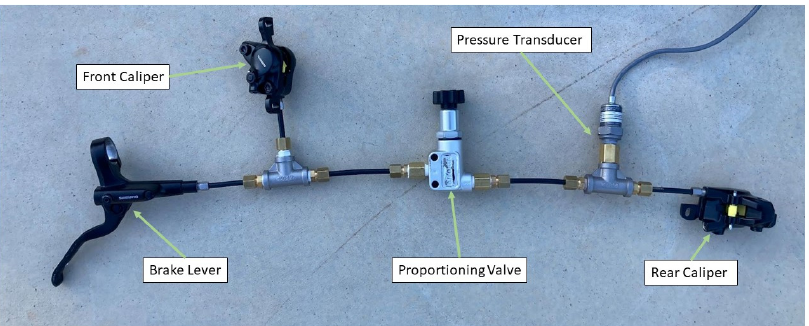
Figure 7. Bench-top prototype brake system including a proportioning valve and pressure transducer (force sensors omitted). Mass, as shown, is 0.85 kg.